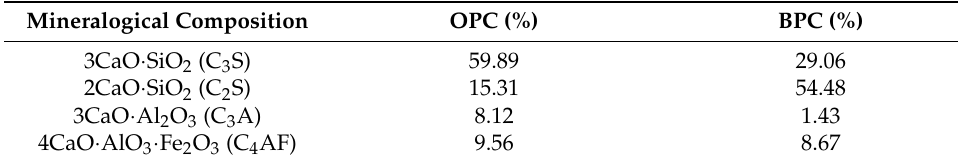
Table 2. Mineralogical composition of the